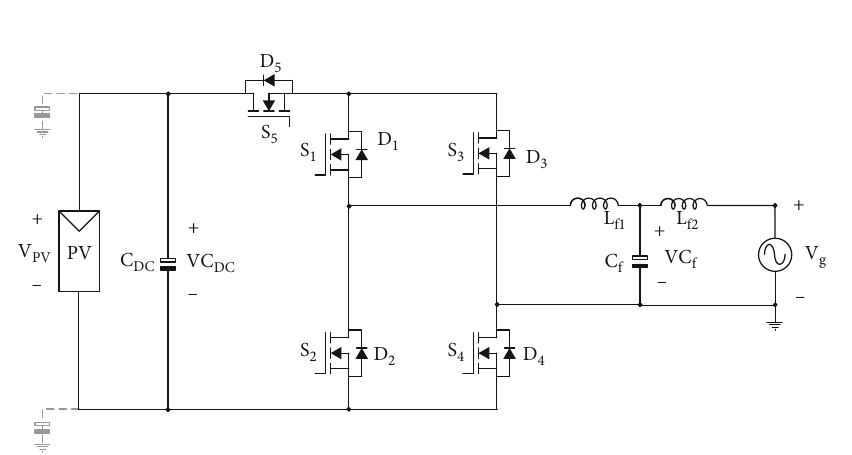
Figure 2: Dual buck inverter.